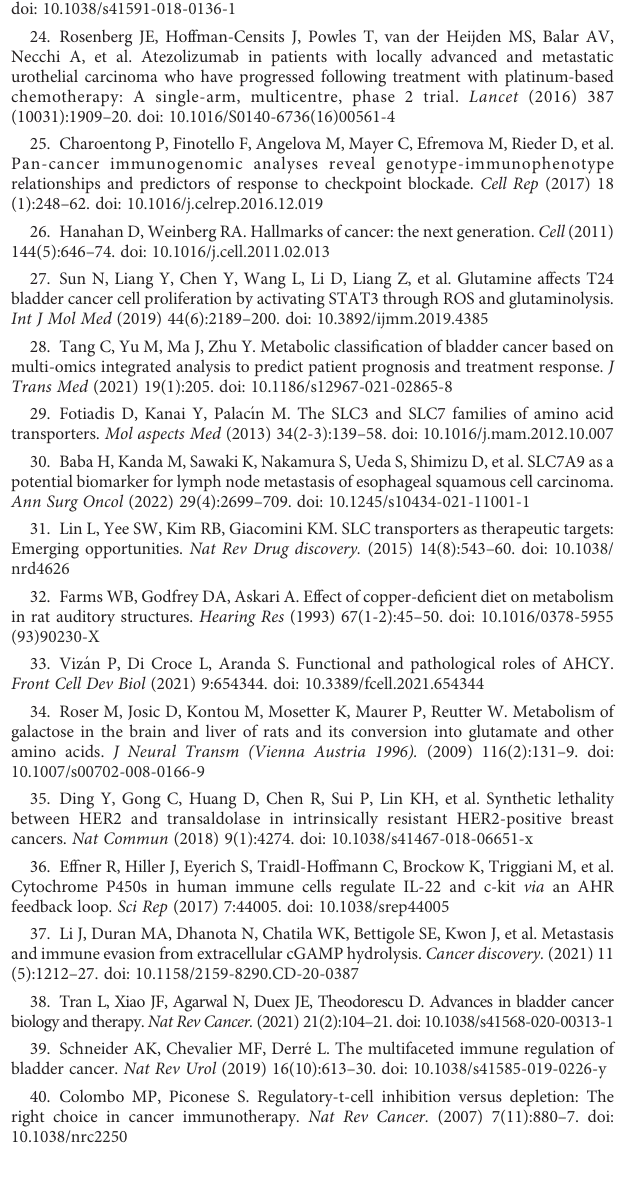
SUPPLEMENTARY FIGURE 7 3D structures of chemotherapeutic drugs with differences between the two groups. SUPPLEMENTARY FIGURE 8 Differences in the expression of common immune checkpoints between high-GMII and low-GMII groups. SUPPLEMENTARY FIGURE 9 Subnetwork and core gene PPARG most closely related to GMII